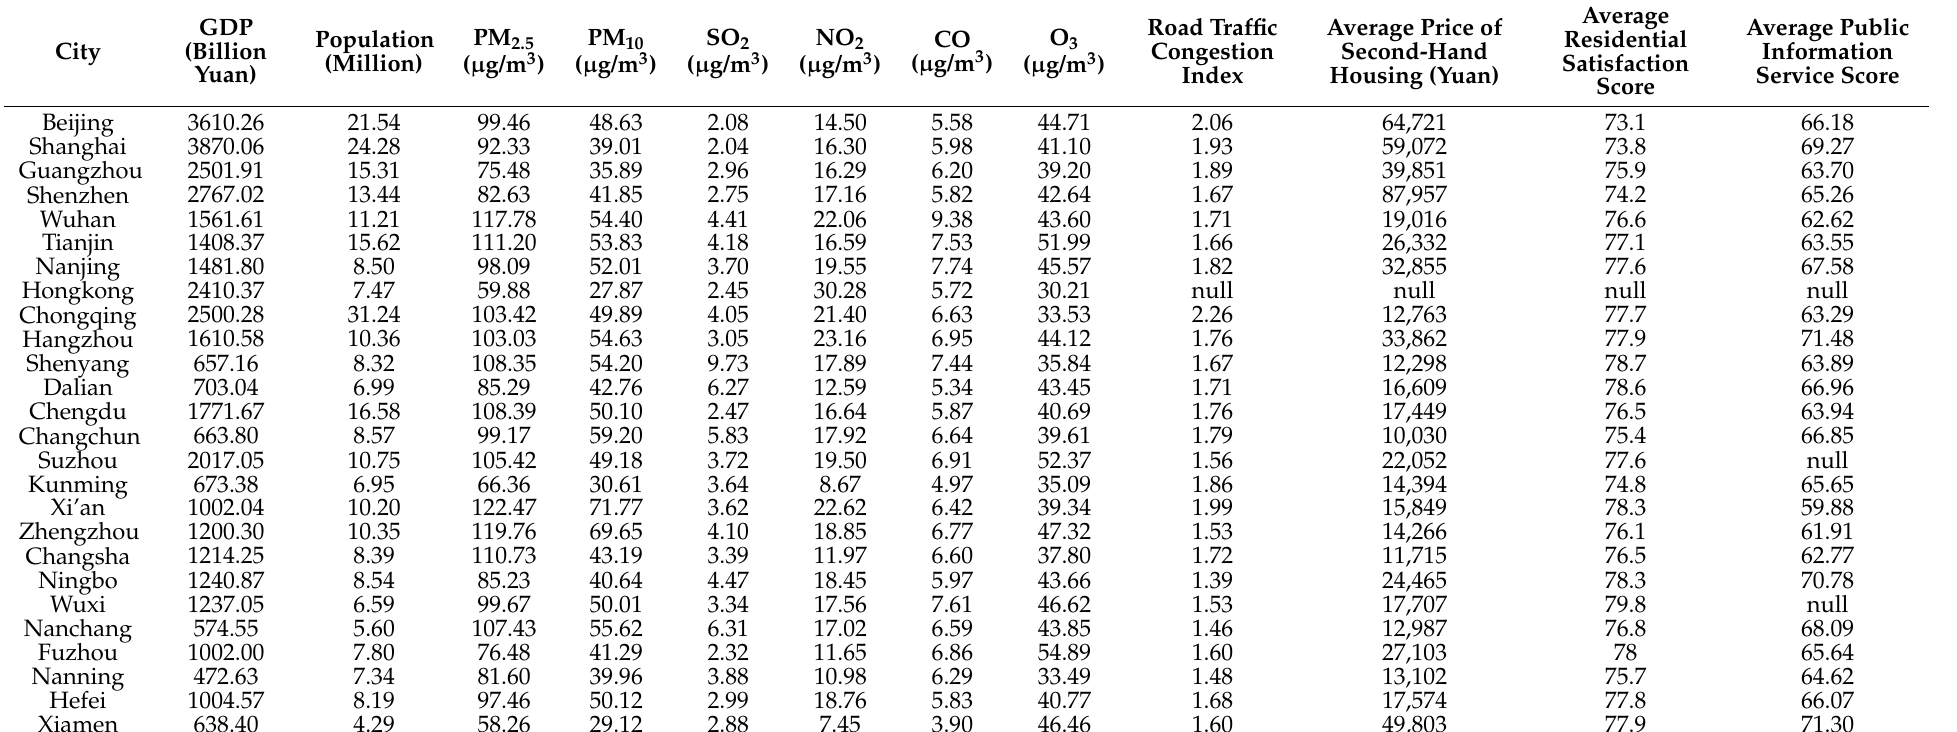
Table 1. Acquired economic, environmental and social data of 26